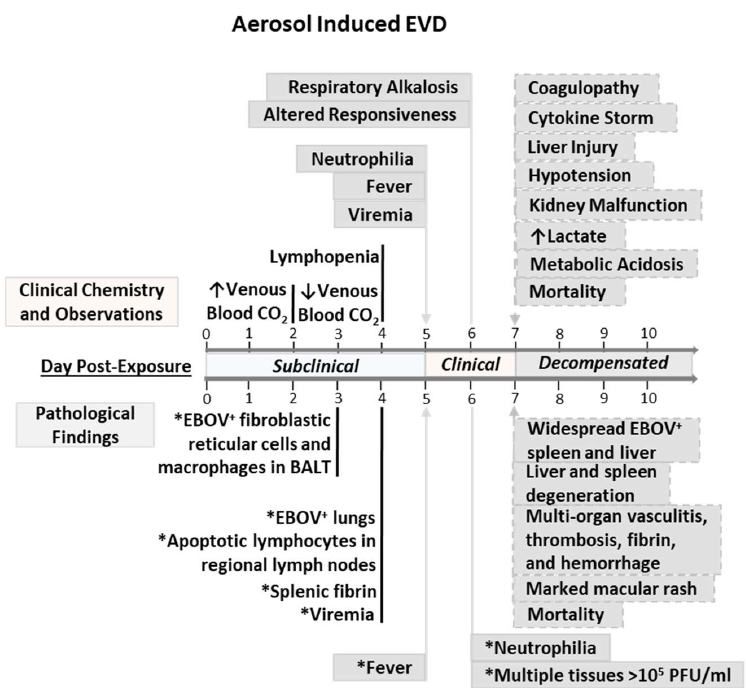
Figure 8. Natural history of aerosol-induced EVD in rhesus macaques. The subclinical stage of disease progression is defined by absence of fever between DPE 0 and 4. The clinical stage of disease progression is defined by fever, as observed on DPE 5 in the current study and the serial sacrifice study by Twenhafel et al. 2012. Multiple tissues (qRT-PCR EBOV-positive) are in descending order: inguinal LN, liver, spleen, tracheobronchial LN, lung, axillary LN, mandibular LN, kidney, adrenal gland, mesenteric LN, and bone marrow. The decompensated stage of the natural history study was identified by coagulopathy, cytokine storm, liver injury, kidney malfunction, and mean clinical score ≥ 2.0. Macular rashes were found on the face, pinna, arms, and legs of animals. Here, the aerosol-induced EVD had an extended subclinical stage, shortened clinical stage, and general decompensated stage when compared to historic intramuscular studies noted in Figure S15 (lymph node = LN; solid black line = subclinical stage; solid gray arrow = start of clinical stage; solid gray line = clinical stage; and dashed gray arrow = start of decompensated stage). * Asterisk pertains to Twenhafel et al. 2012.